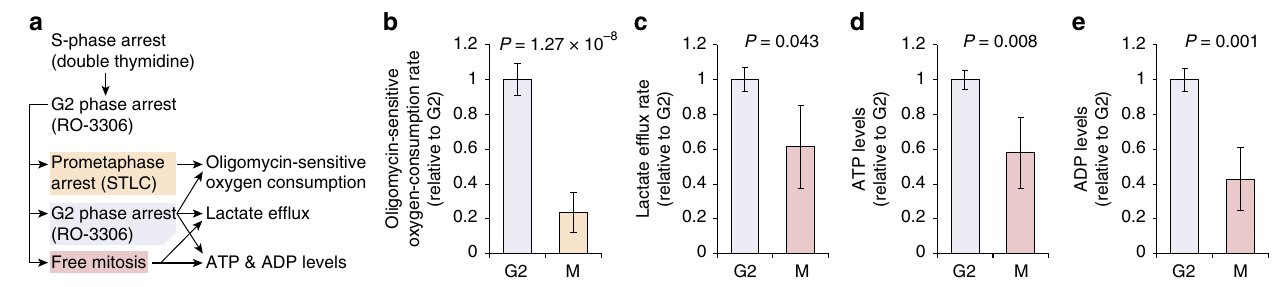
Fig. 5 Flux measurements in synchronized cell populations reveal decreased ATP synthesis and ATP levels in mitosis relative to G2. a Schematic of cell cycle synchronization procedure. Oxygen-consumption rates were measured using cells arrested in mitosis due to the time needed to obtain measurements. Lactate ef fl ux and ATP and ADP levels were measured in cells progressing through mitosis. All results were normalized by the number of cells in mitosis and G2. b Oligomycin-sensitive oxygen-consumption rate, i.e., mitochondrial ATP synthesis rate, in G2 and mitotic cells ( N = 7 – 8 independent synchronizations and cultures). c Lactate ef fl ux rate in G2 and mitotic cells ( N = 4 independent synchronizations and cultures). d ATP levels in G2 and mitotic cells ( N = 5 independent synchronizations and cultures). e ADP levels in G2 and mitotic cells ( N = 5 independent synchronizations and cultures). For panels ( b – e ), data depict mean ± SD (compound errors after accounting the mean values for imperfect cell cycle synchrony). Unpaired, two- tailed Student ’ s t test was used for statistical